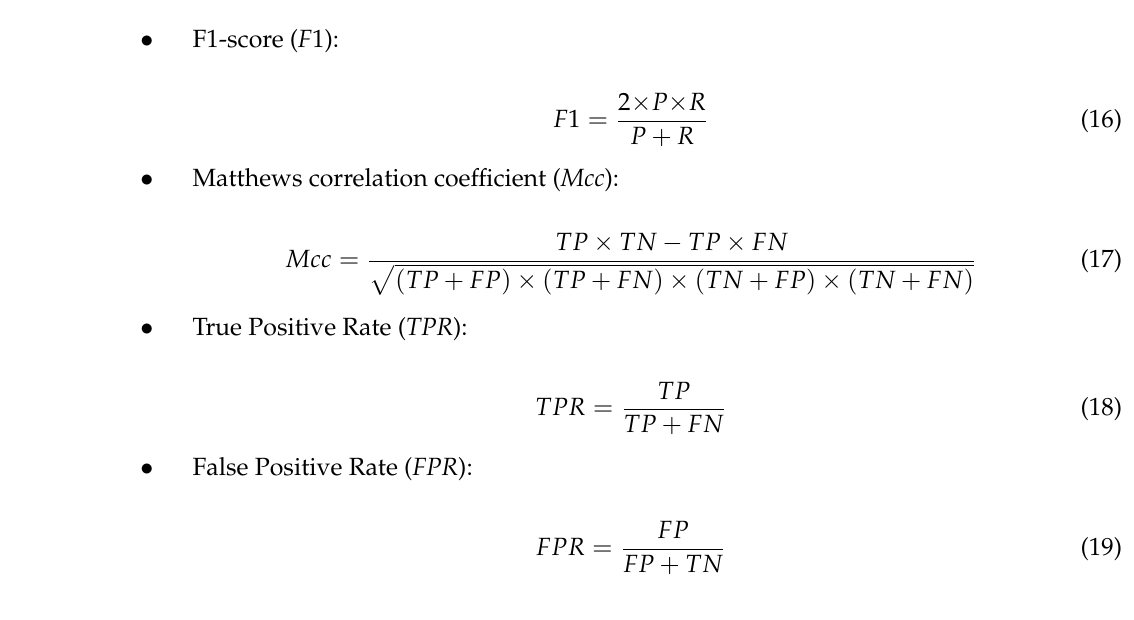
Table 5. Comparison of classification performance of different ideas.